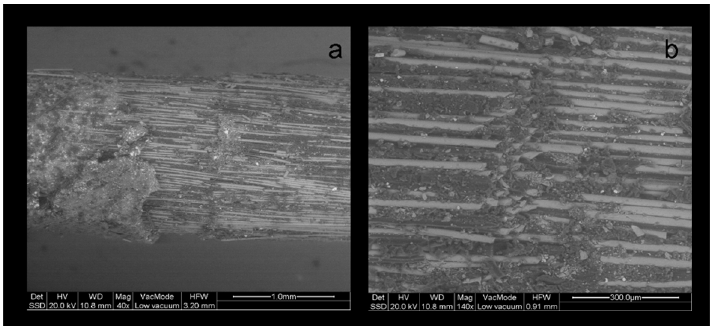
Figure 8. BE LV-SEM image of a fractured PRW post, ( a ) with details of the sheared off spherical protrusions ( b ) and the cut fibers at the contact of the protrusions with the main body (a: 40×, bar = 1 mm, b: 140×, bar = 300 μ m).